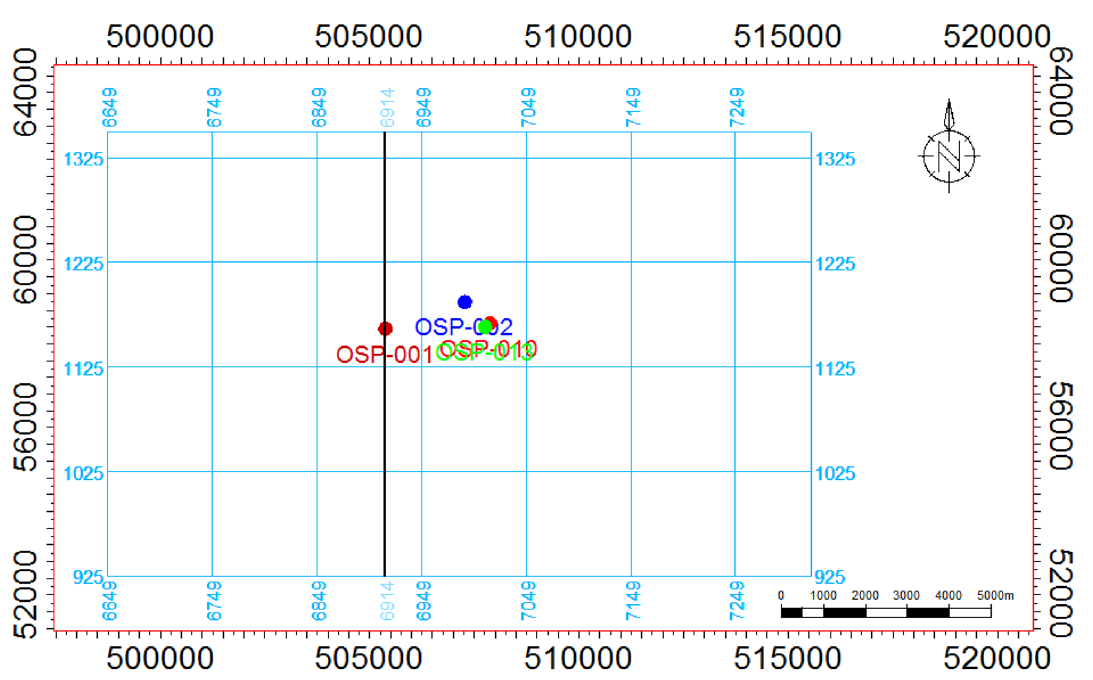
Fig. 4 Base map of the study area showing well locations. Note : the seismic inline that was discussed in this study is in thick black (inline